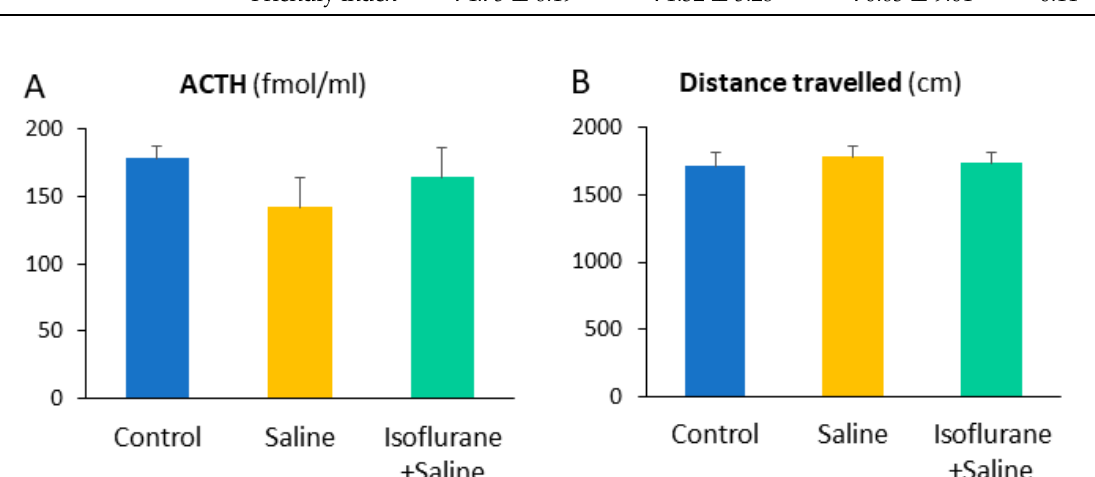
Figure 2. Serum ACTH ( A ) and locomotor ( B ) parameters 30 min after interventions. The comparison of the three groups of C57Bl/6 male mice did not reveal any differences (n = 10–11/group).